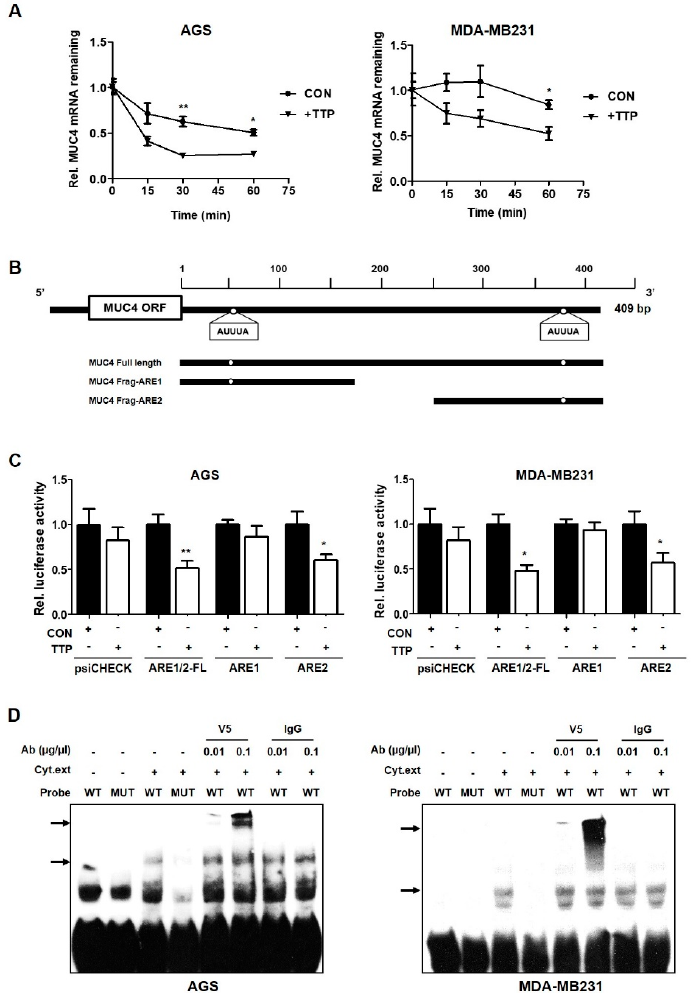
Figure 3. TTP binds directly to the ARE in the 3’UTR of MUC4 mRNA and makes it unstable. ( A ) After addition of actinomycin D to cells transfected with pcDNA6 / V5 or pcDNA6 / V5-TTP, the remaining MUC4 mRNA was examined. * p < 0.05; ** p < 0.01. ( B ) A schematic map of the luciferase reporter constructs. The two white circles represent the binding motif AUUUA in the MUC4 3 (cid:48) UTR. The ARE1 construct contains first AUUUA and ARE2 involved a second AUUUA. ( C ) Cells were co-transfected with a luciferase reporter vector (containing three types of AREs in the MUC4 3’UTR region) and a pcDNA6 / V5-TTP or empty pcDNA6 / V5 control vector. Renilla luciferase activity was normalized to firefly activity. The luciferase values obtained from cells co-transfected with a luciferase construct and pcDNA6 / V5 were set to 1. The results shown on the graph represent the mean ± S.D. of three independent experiments. * p < 0.05; ** p < 0.01. ( D ) An RNA-EMSA assay was performed by mixing cytoplasmic extracts containing 10 µ g of total protein with 10 fmol of biotinylated wild-type (WT) probe (AUUUA) and a mutant probe (AGCGA). Anti-TTP and control antibodies were added to the reaction mixtures. The binding reactions were then separated by electrophoresis on a 5% polyacrylamide gel under non-denaturing conditions. Arrows indicate the position of the TTP-containing